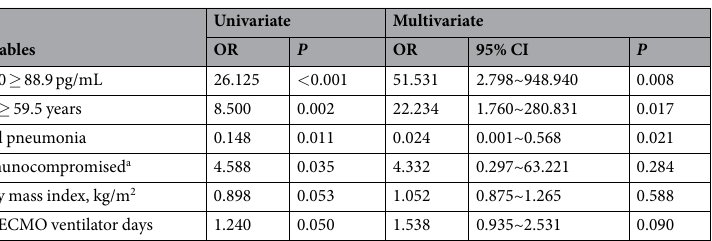
Table 2. Univariate and multivariate logistic regression analyses for independent predictors of ICU mortality in the patients of this study. OR, odds ratio; CI, confidence interval. a Defined as hematological malignancies, solid tumor, solid organ transplantation and/or